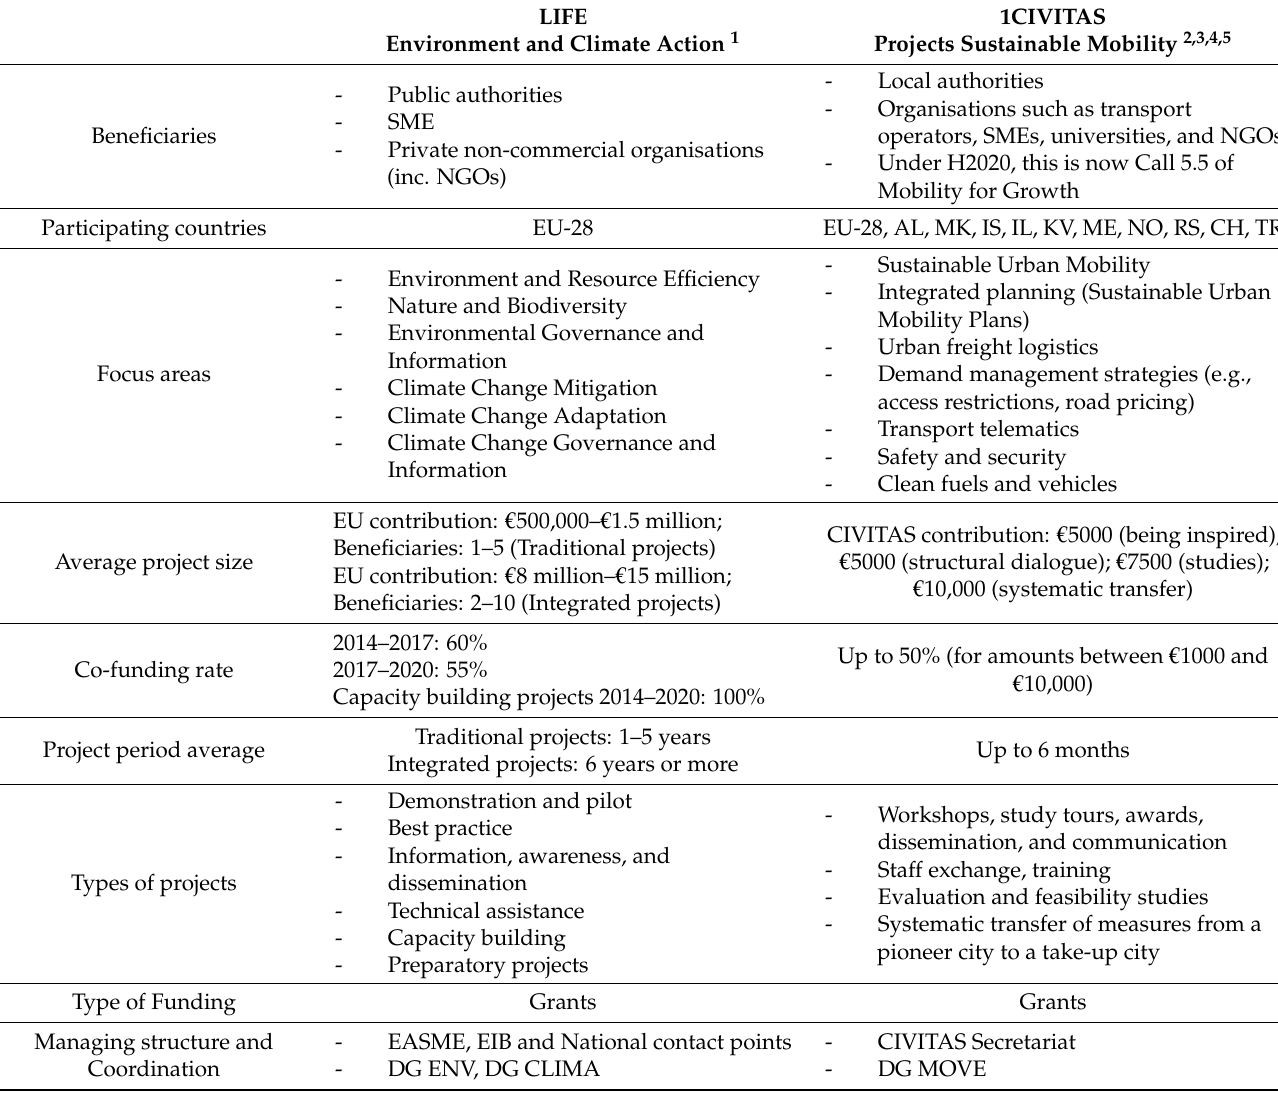
Table A2. European funding